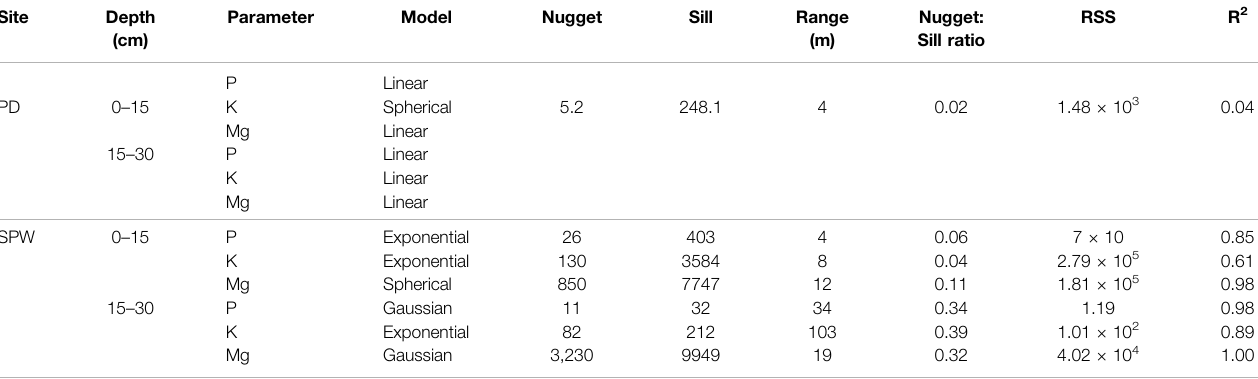
TABLE 7 | Spatial dependence of plant available nutrients in the surface and subsurface horizons of the rewetted and drained peatlands. Site